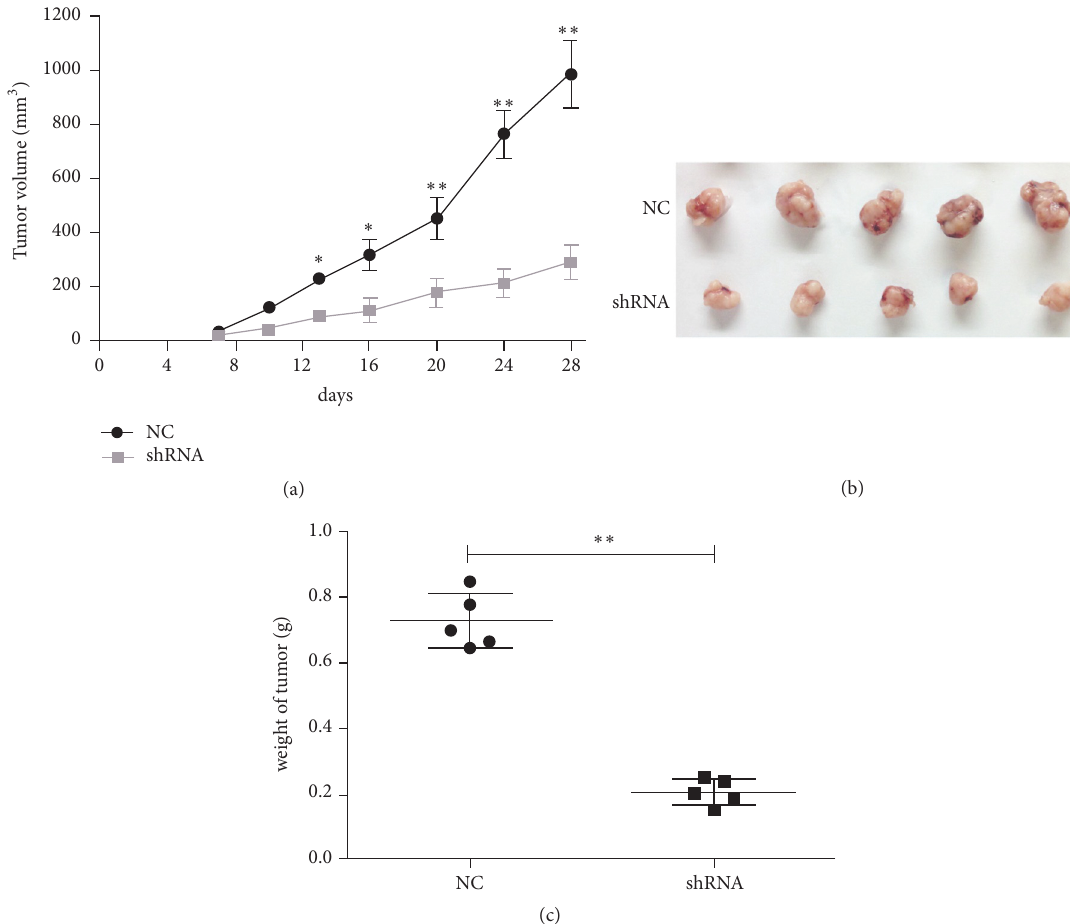
Figure 4: Knockdown of MIR4697HG inhibits tumor growth in vivo. (a) A xenograft model of ovarian cancer was established using SKOV3 cells with (shRNA group) or without (NC group) MIR4697HG depletion. Tumor size was periodically monitored. (b) Tumors were dissected from each mouse and shown for each group. (c) Dissected tumors were weighed for each group. It was shown that the average tumor weight was significantly less in the shRNA group, accounting for only 71% of that in the control group. ∗ 𝑝 < 0.05 ; ∗∗ 𝑝 < 0.01